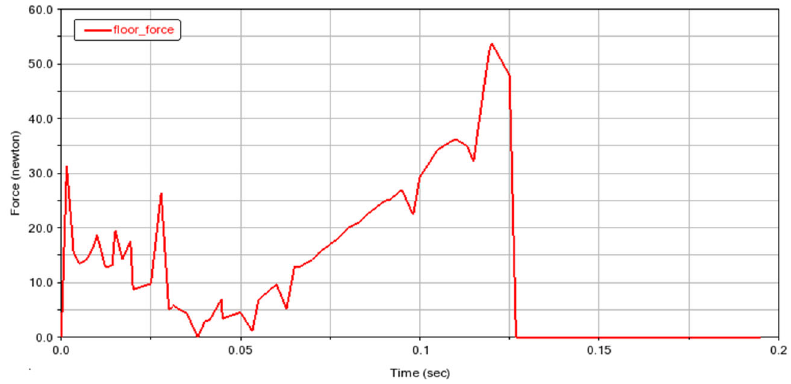
Figure 7. The ground reaction force of the ankle in simulation.